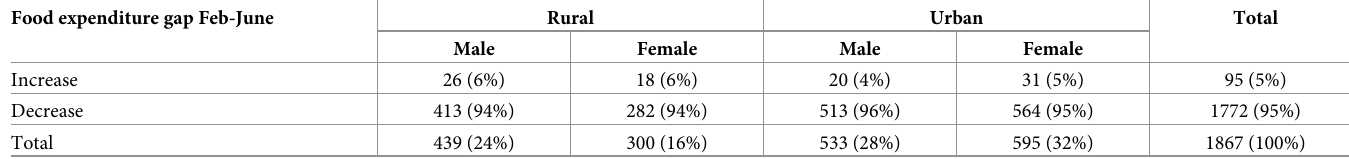
Table 4. Frequency and percentages of the food expenditure gap between February and June 2020 according to area and gender.